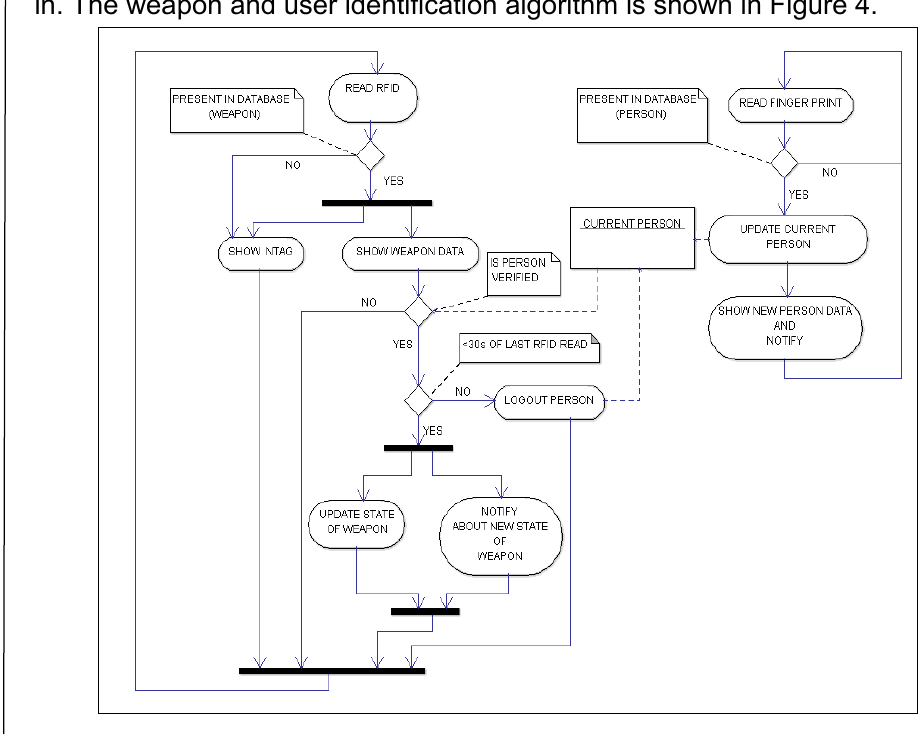
Figure 4 – Weapon and user identification